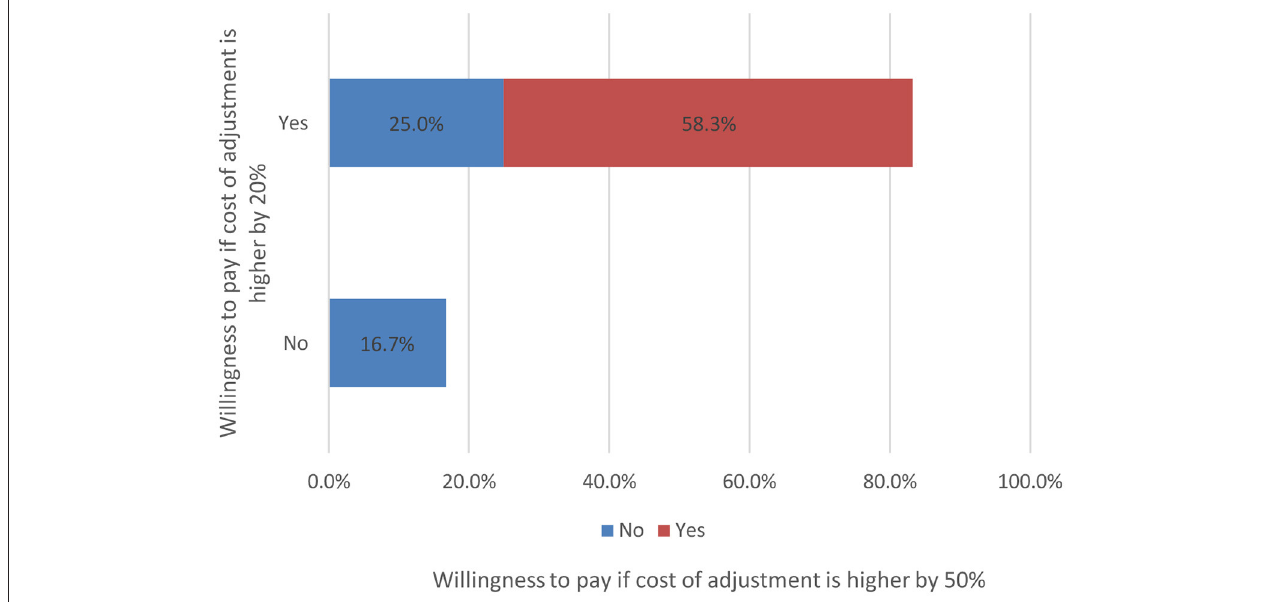
FIGURE 10 | Willingness to pay if the costs of adjustments were 20% and 50% above the respondents’ initial proposed